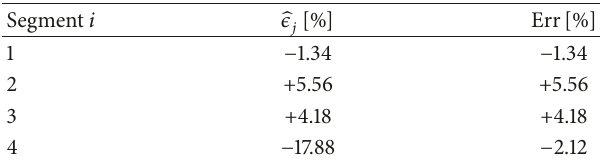
Table 17: Damage evaluation on the continuous bending moment- deflecting structure, by using SVD-based